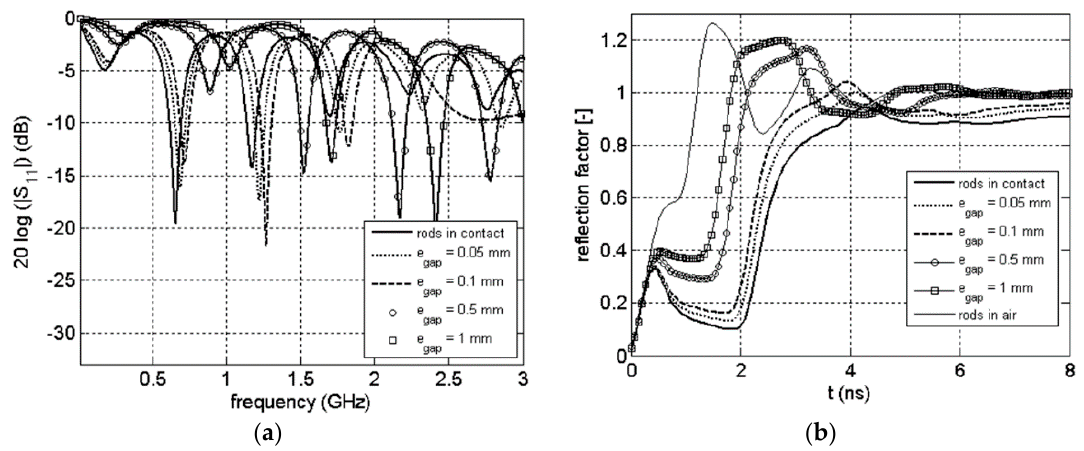
Figure 8. Magnitude of scattering function S 11 ( ω ) ( a ), corresponding TDR waveform ( b ) for the probe surrounded by air and clay rock ( θ = 0.022 m 3 /m 3 ). Sensors 2016 , 16 , 554